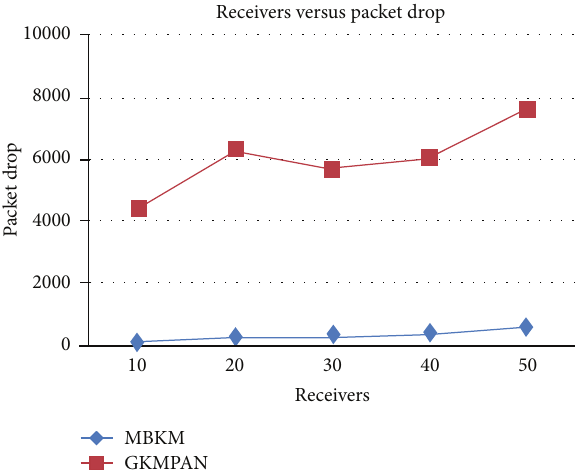
Figure 6: Comparison of delivery ratio with GKMPAN for varying receivers.